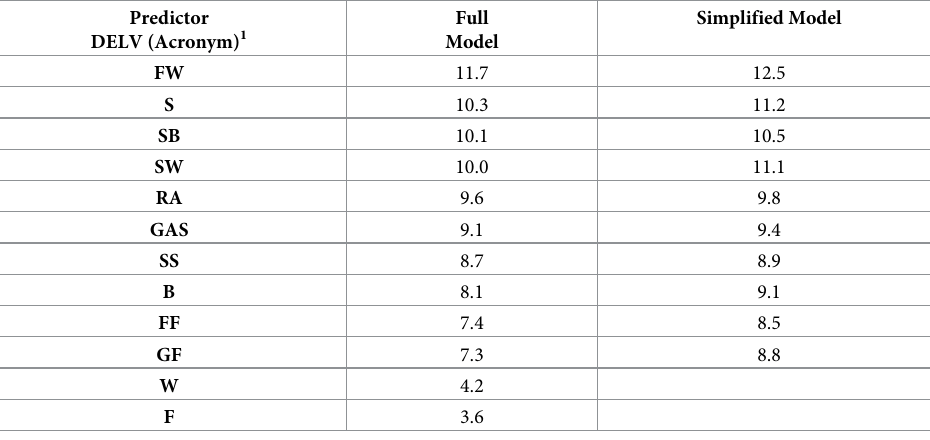
Table 2. The relative contributions (%) of the (DELV) predictor variables for BRT full and simplified models. Developed with cross-validation on data from 332 sites and a tree complexity of 12 and 10 respectively. The full model was fitted with 12 predictors and least contributing 2 were removed and the simplified model was fit with the remain- ing 10 predictors; Figs C1 and C2 in S1